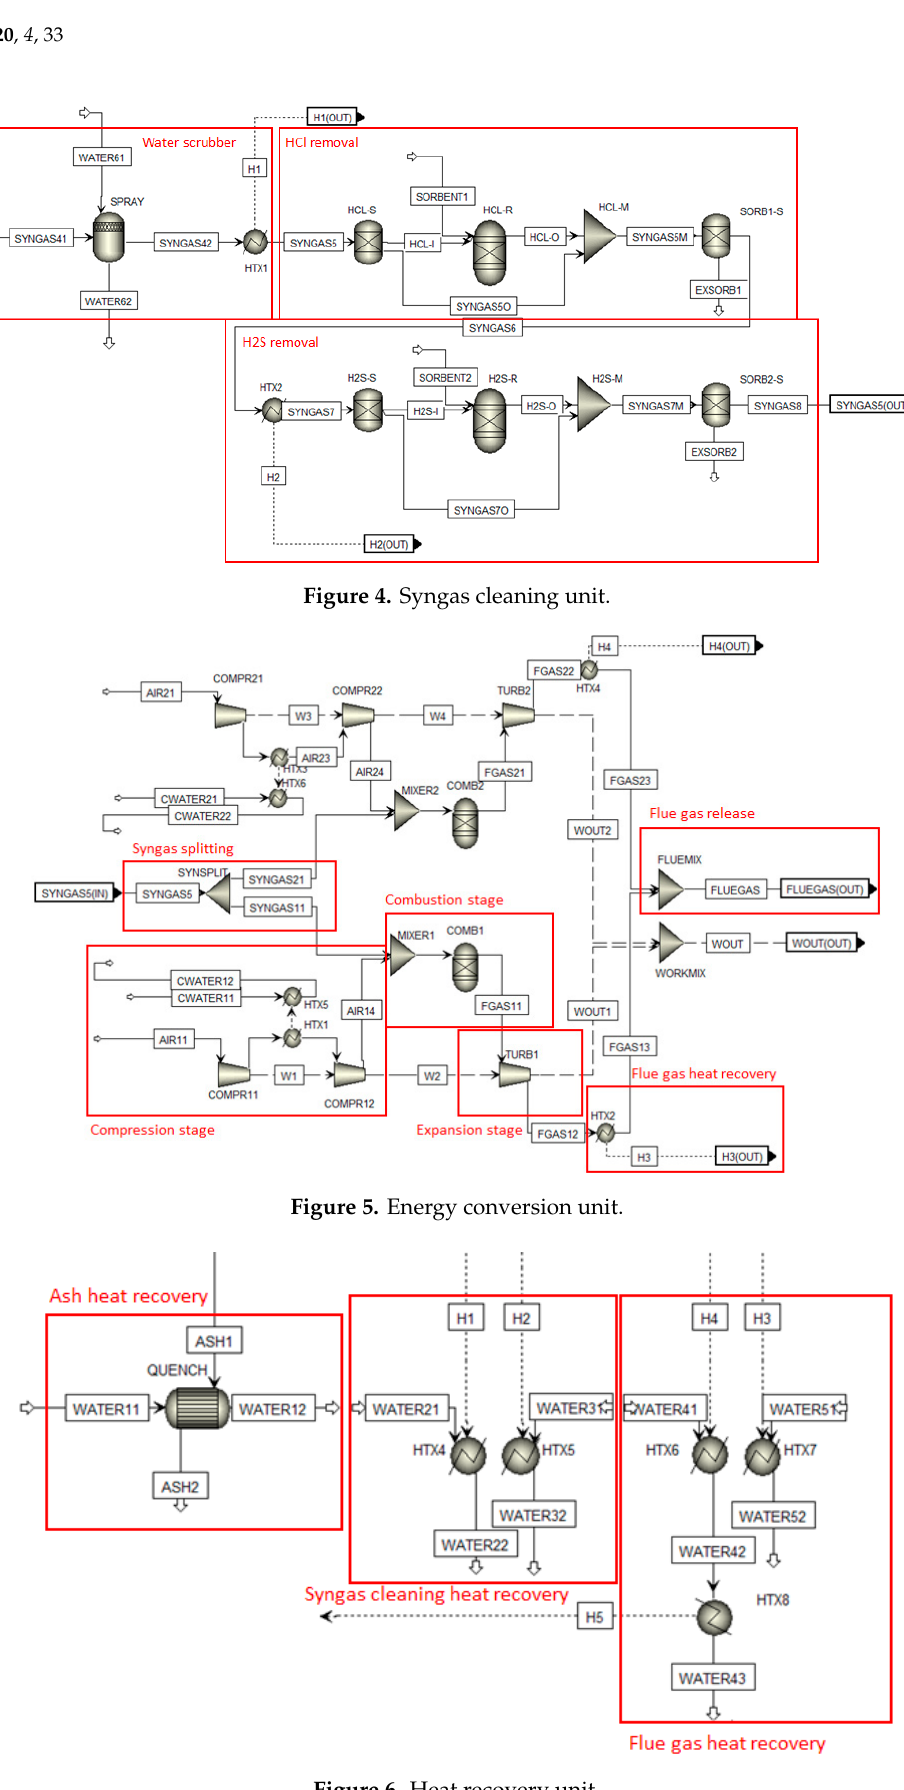
Figure 6. Heat recovery unit.